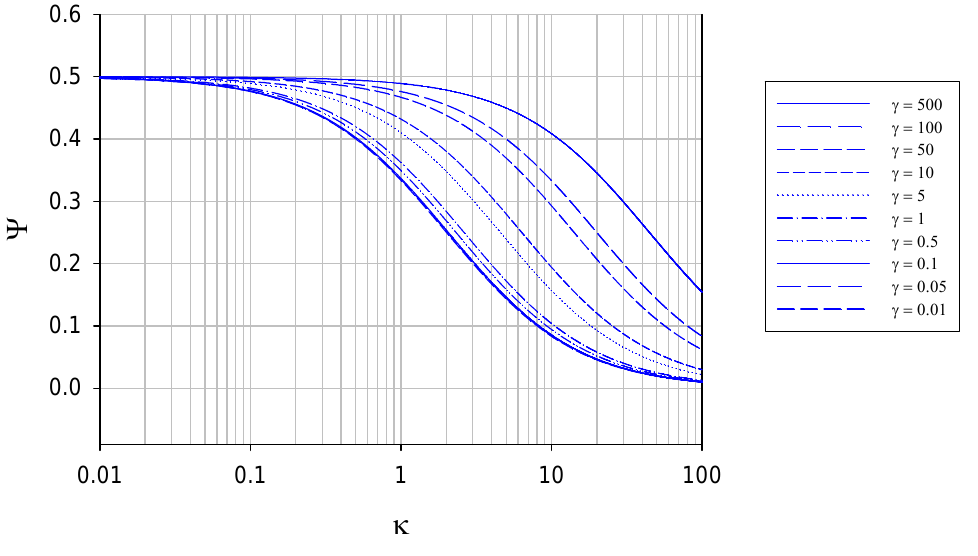
Figure 5. Variation of normalized flux Ψ with reaction/diffusion parameter κ for various fixed values of the parameter γ . The curves were calculated using eqn.13 in the